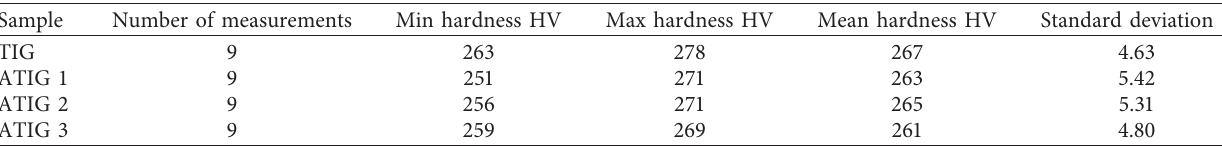
Table 12: Measurements of hardness of TIG and ATIG in